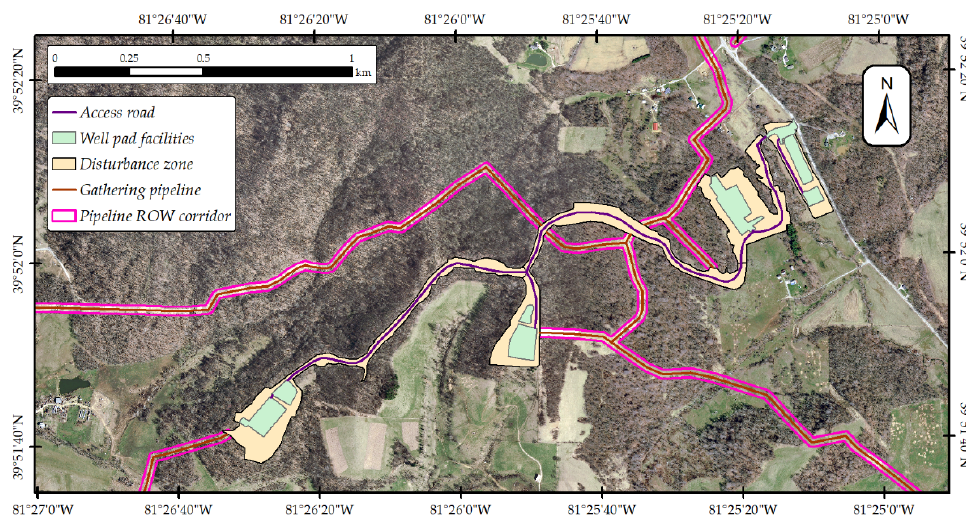
Figure 4. Example of digitized landcover changes caused by shale gas extraction activities.